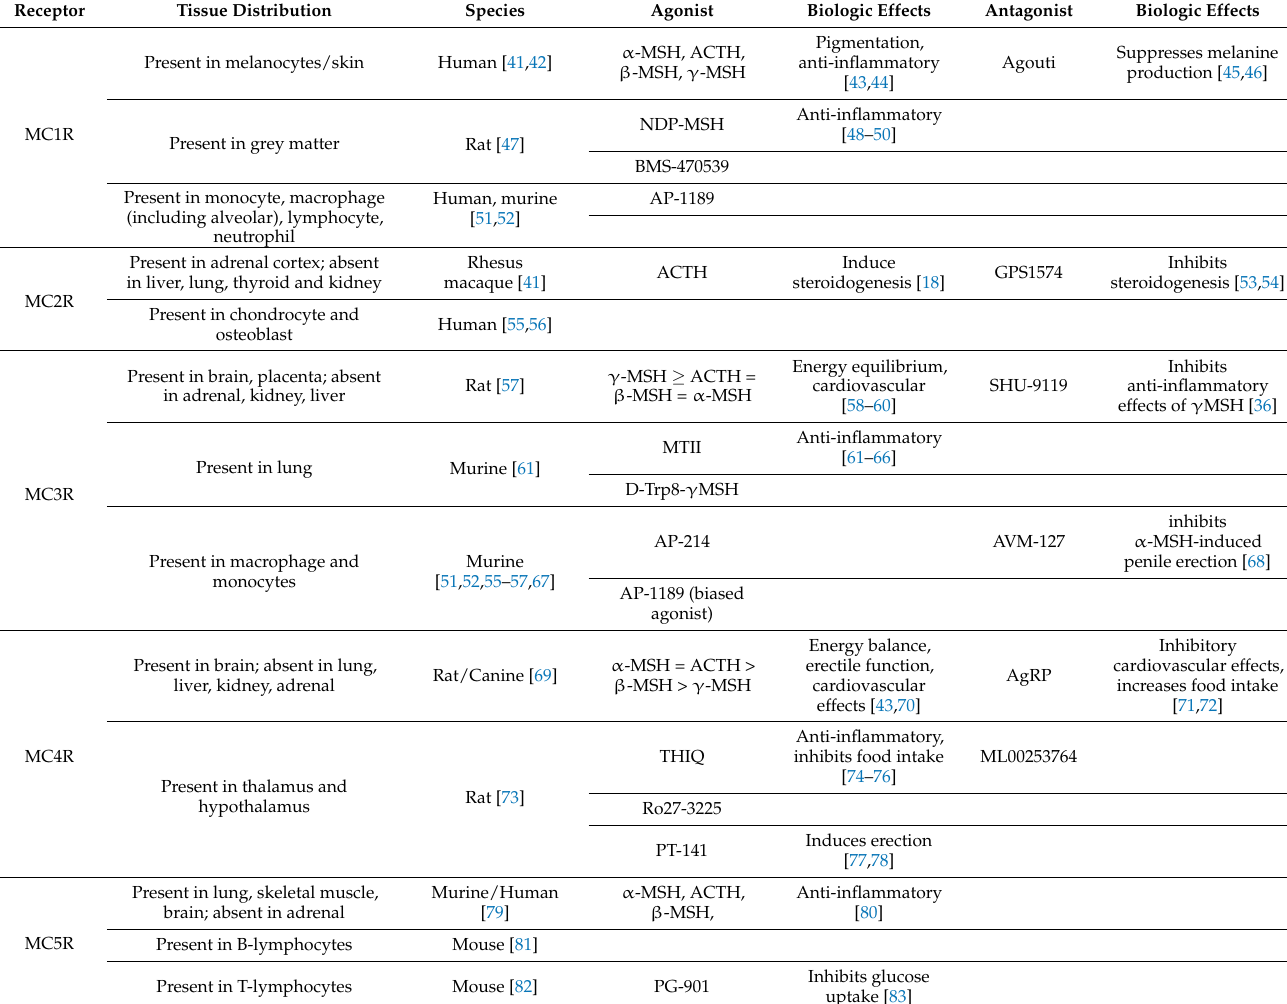
Table 1. Melanocortin receptors; tissue distribution, known agonists and antagonists, and their biological effects.